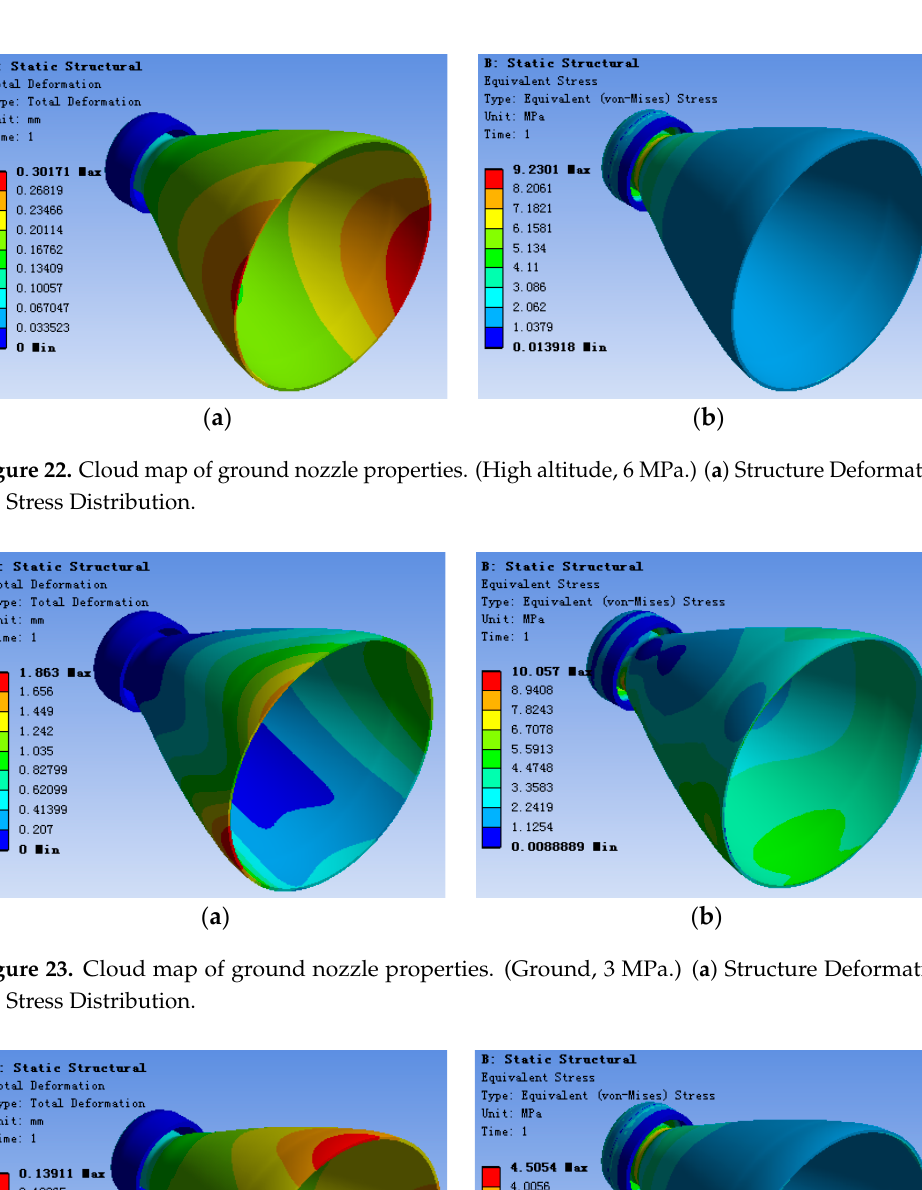
Figure 21. Cloud map of ground nozzle properties. (Ground, 6 MPa.) ( a ) Structure deformation. ( b ) Stress distribution.